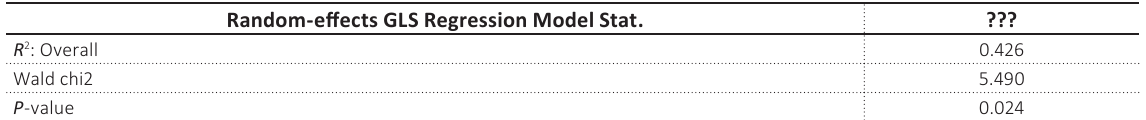
Table 10. Goodness of fit of the model Random-effects GLS Regression Model Stat.